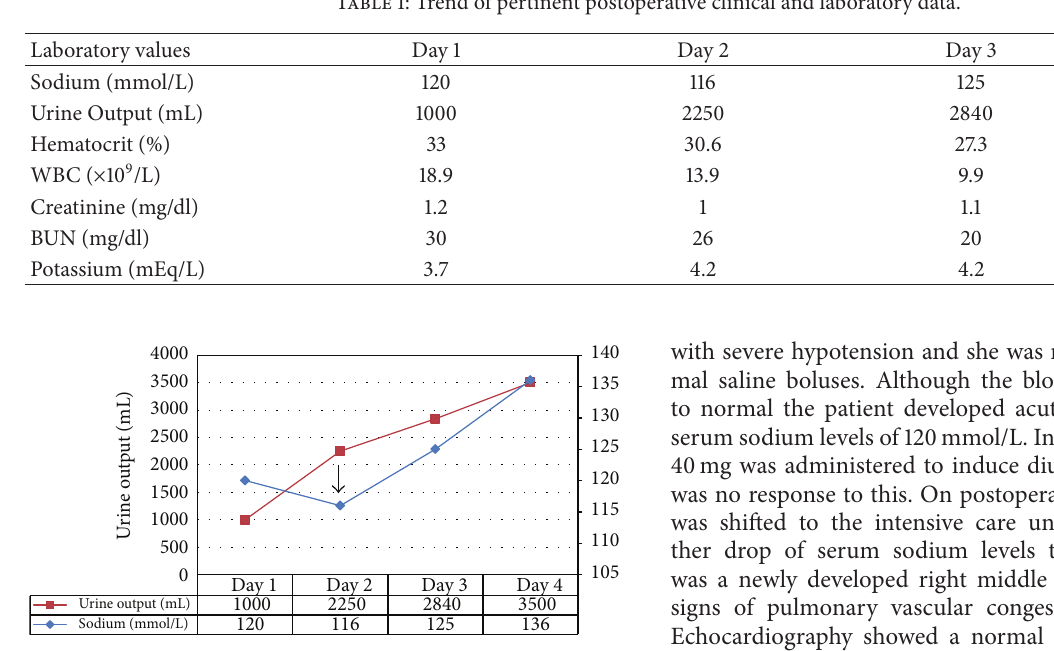
Figure 1: Trend of postoperative urine output and serum sodium levels from postoperative day 1 to day 4 during immediate postop- erative period showing acute hyponatremia and acute renal failure followed by immediate recovery on administration of tolvaptan. Arrow represents administration of tolvaptan on Day